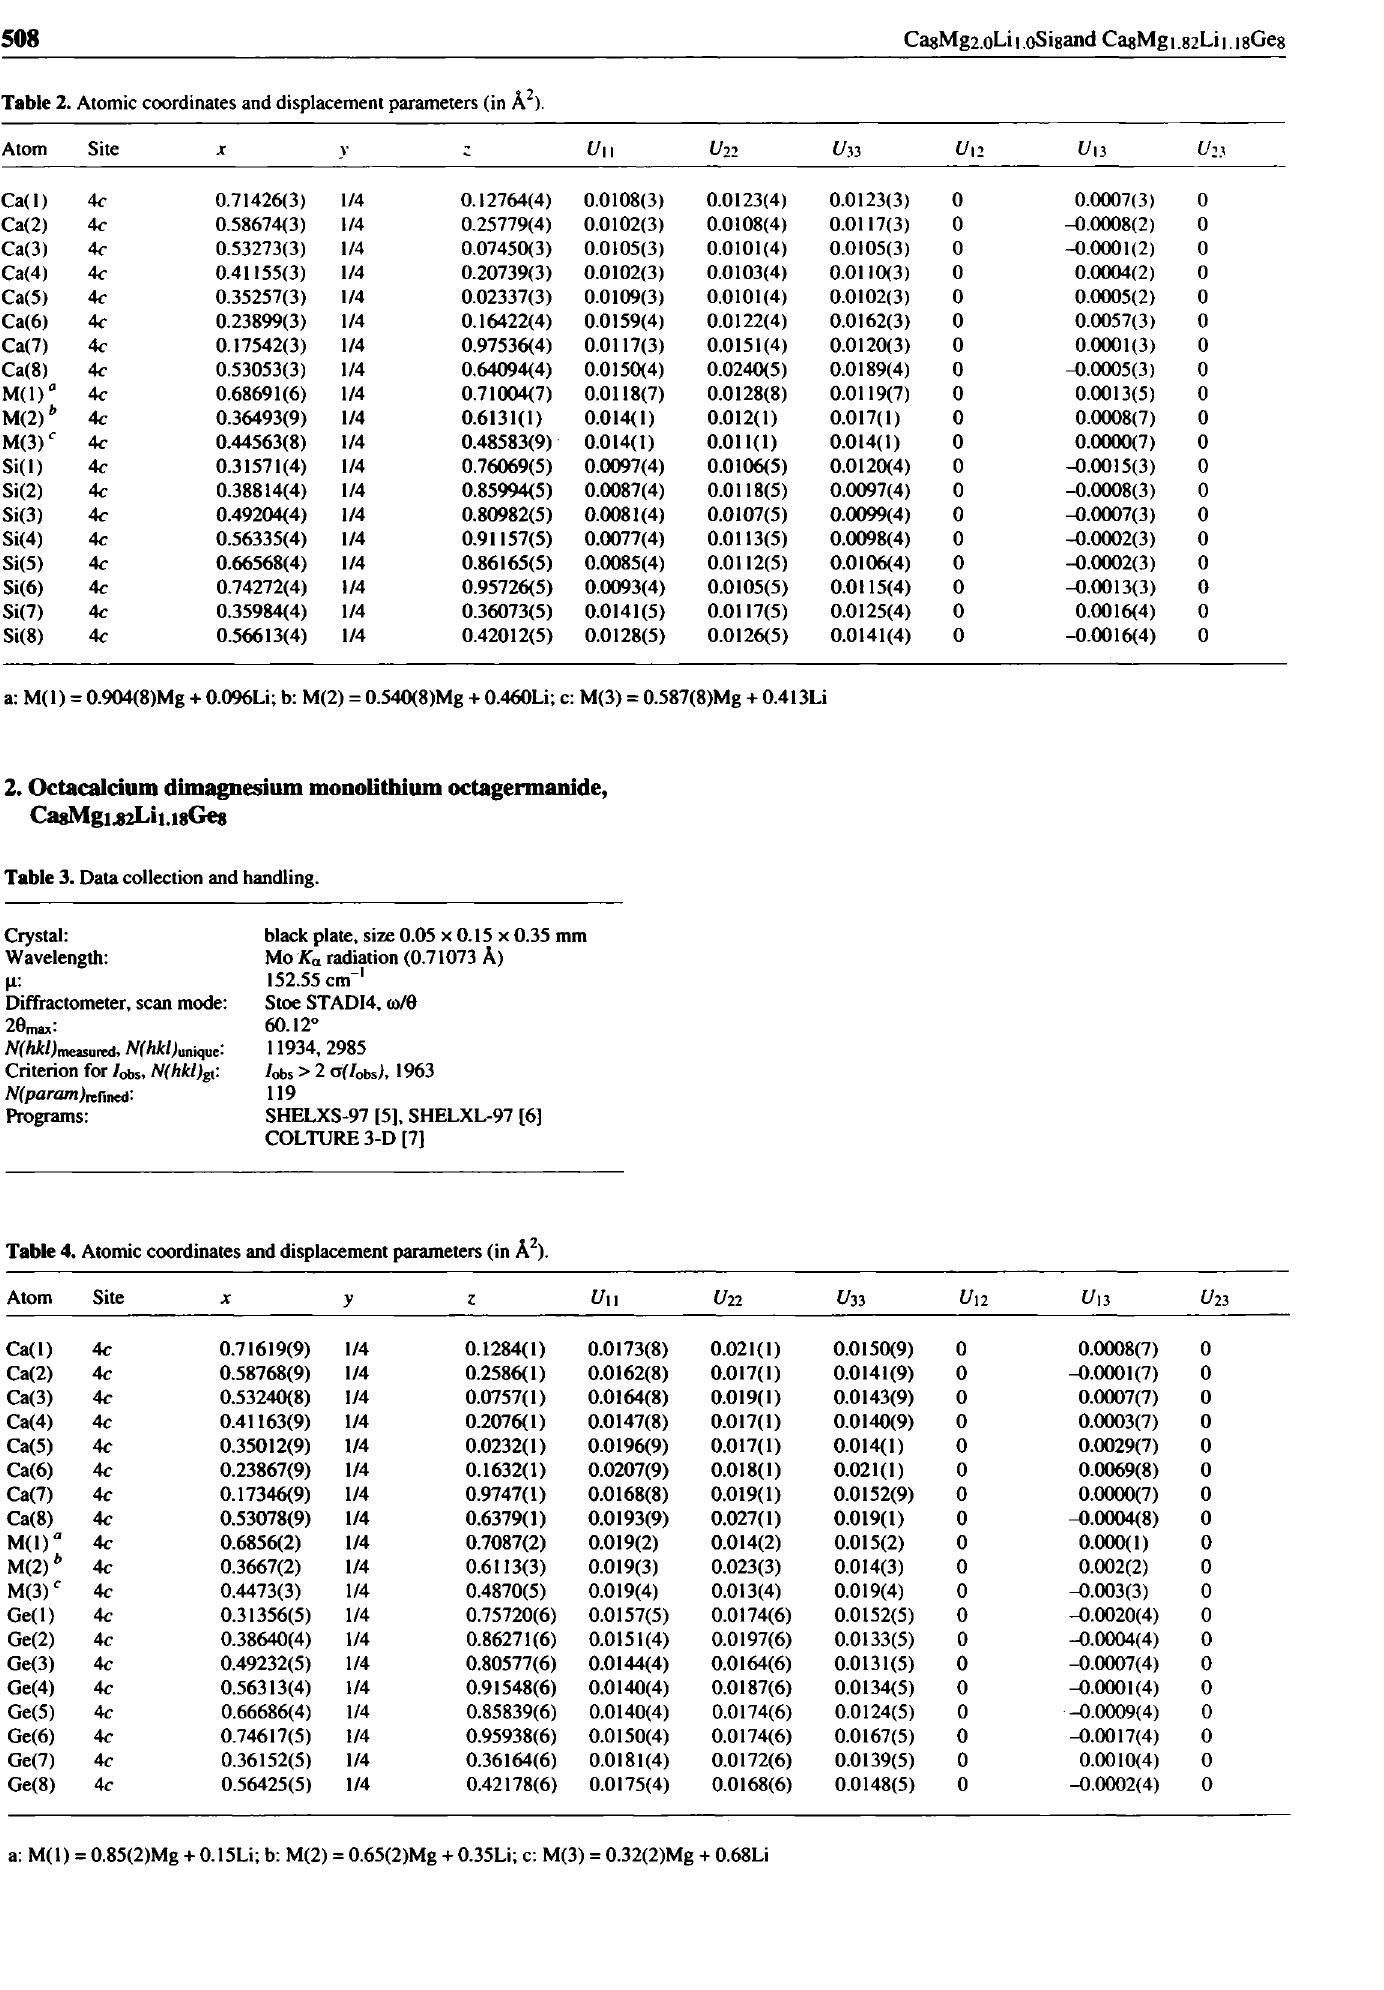
Table 2. Atomic coordinates and displacement parameters (in A 2 ).